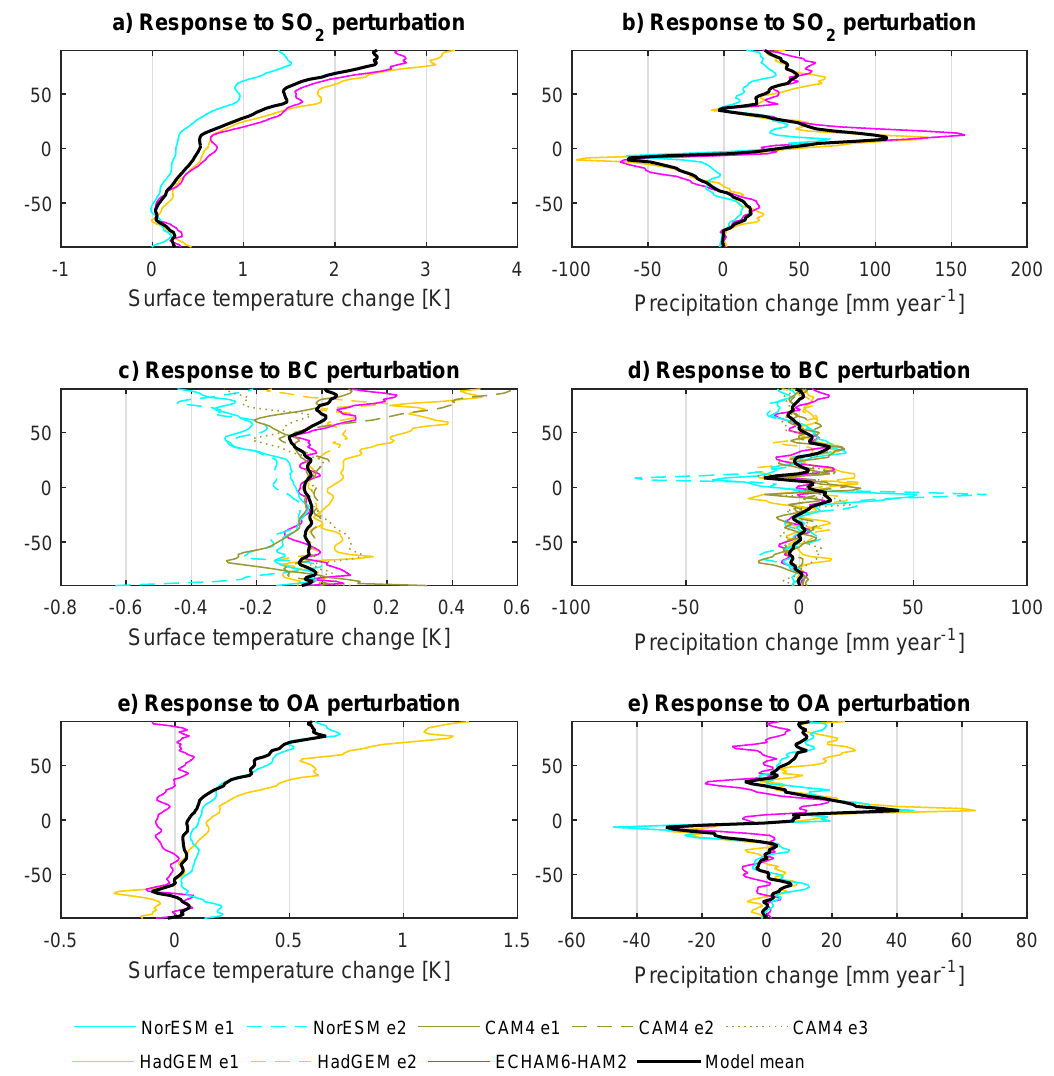
Figure 13. Annual mean changes in zonal-mean surface temperature (left panels a , c , e ) and precipitation (right panels b , d , f ) for a complete removal of all land-based emissions of (a–b) SO 2 , (c–d) BC, and (e–f) OA. For BC, some models ran two or three ensemble members (e1, e2, e3). Notice the differences in scales between different